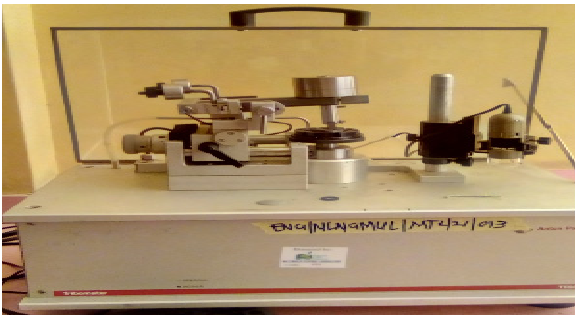
Figure 2. Arton Paar tribometer used for the experiment.